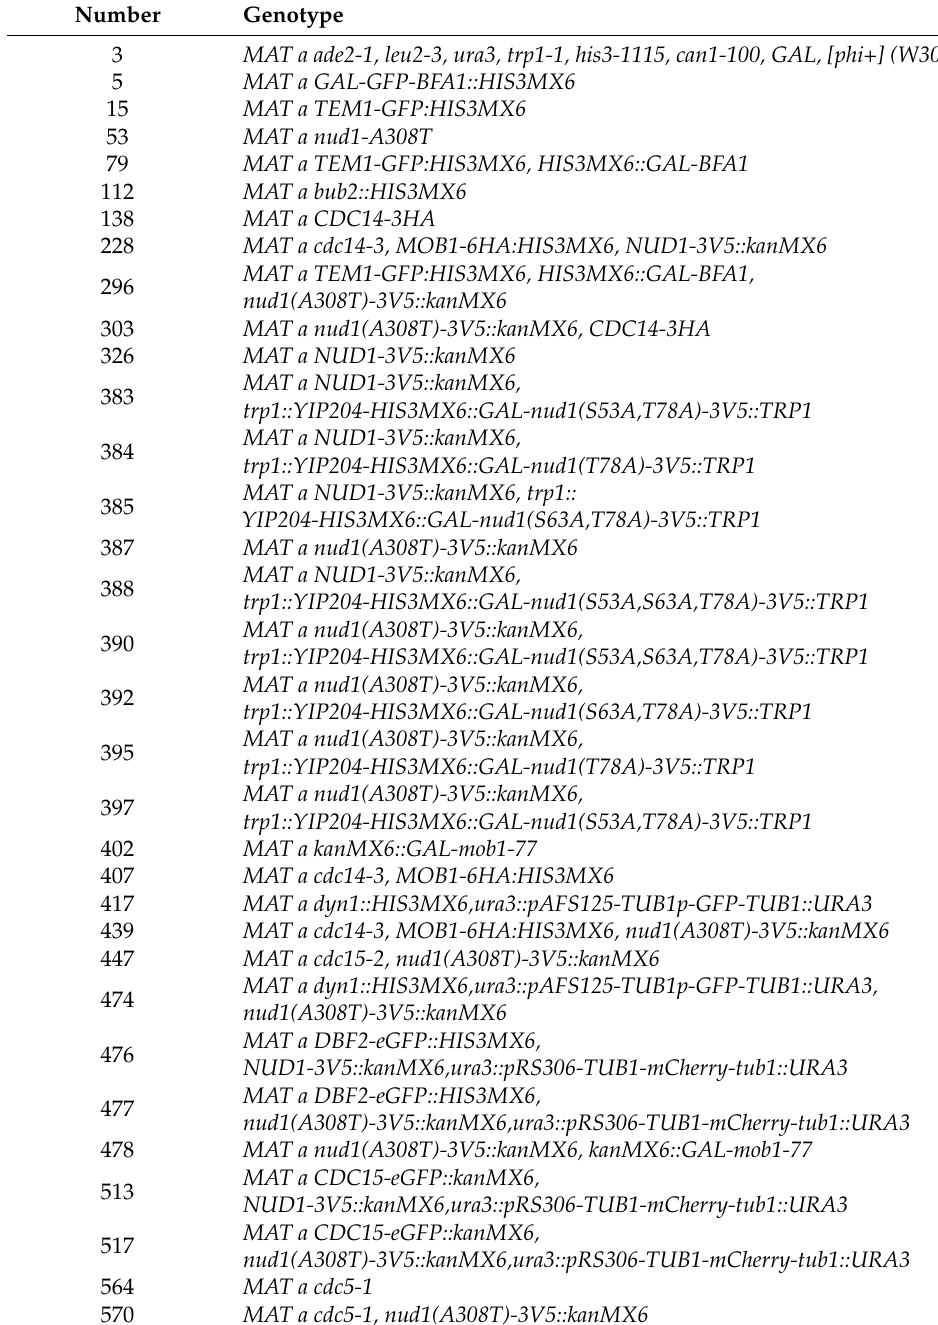
Table 1. Strains used in this study. All strains are derivatives of W303